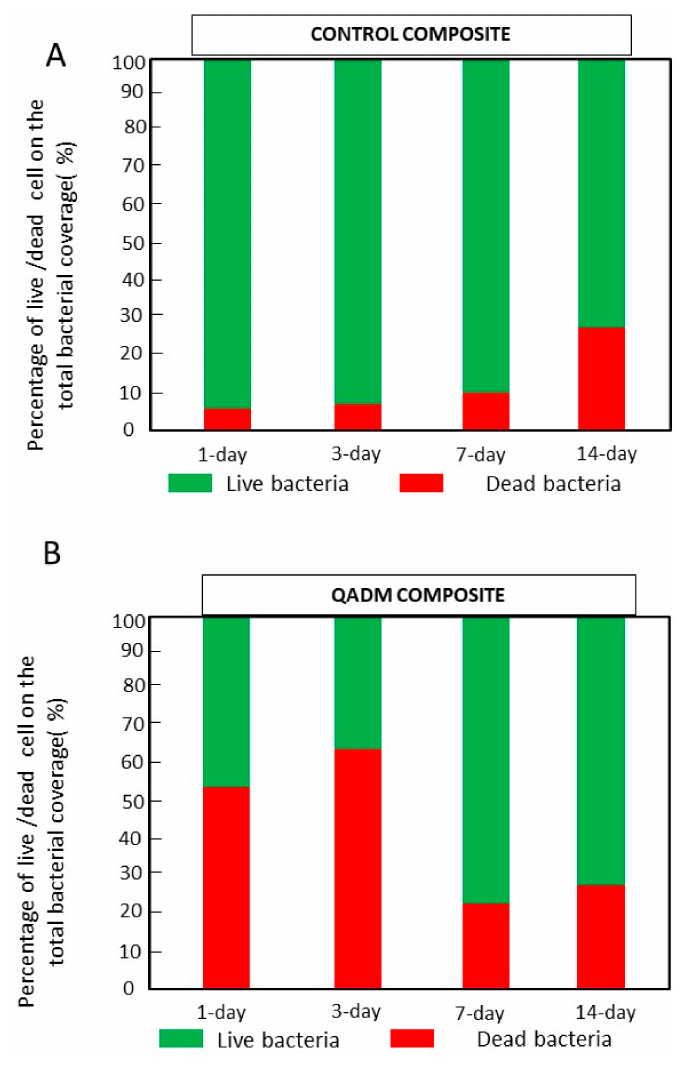
Figure 4. The percentage of live/dead bacterial cells found for the total biofilm coverage over the ( A ) control and ( B ) QADM composites. An increase in the dead percentage was observed for the biofilm grown over the QADM composite during the first and third